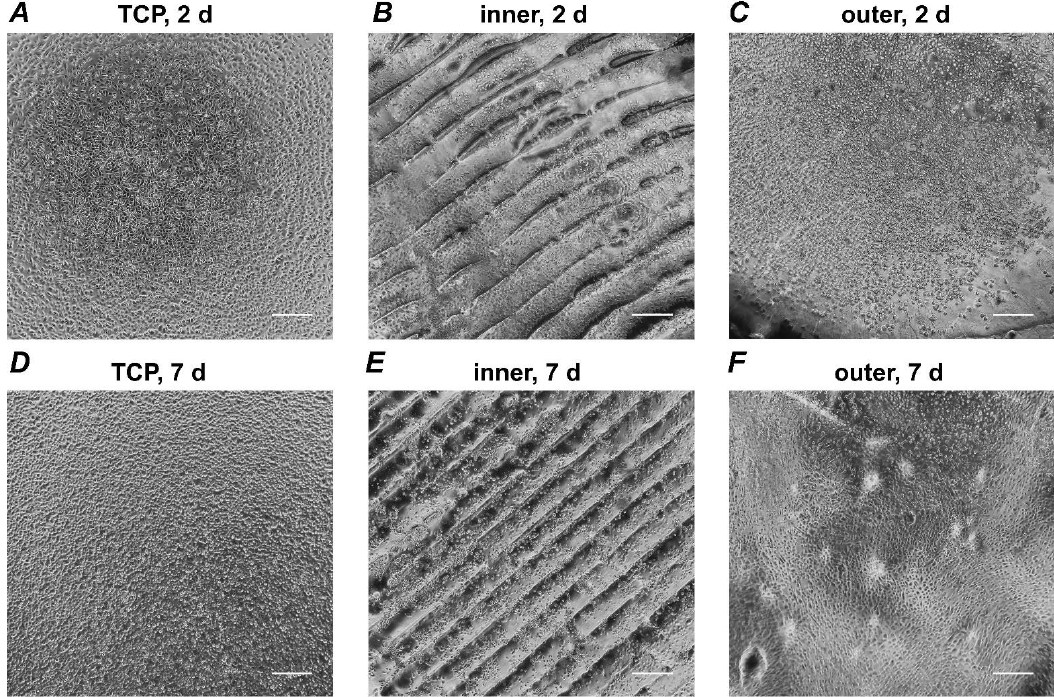
Figure 2. Brightfield microscopy images of HOKs. HOKs were grown on two different aligner surfaces and TCP as control. Pictures were taken at four-fold magnification. Cells were seeded on TCP as control ( A , D ), inner ( B , E ) and outer ( C , F ) aligner surfaces. Pictures were taken after 2 (upper row) and 7 days of culture (lower row). Scale bars correspond to 200 µm.